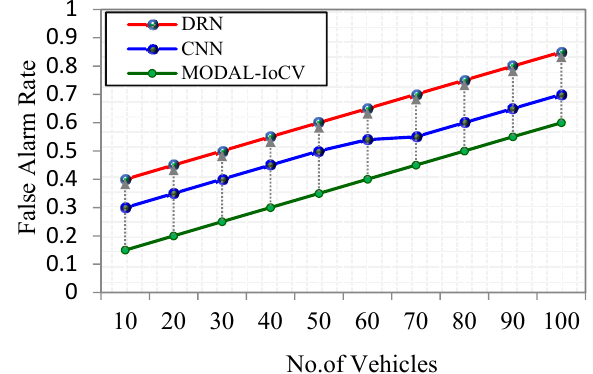
Figure 13. Number of vehicles vs. false alarm rate.